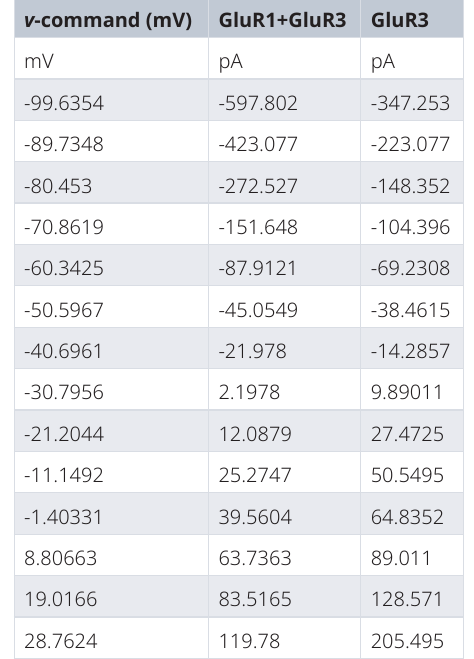
Table 2. Current-voltage relationships for AMPA-Kainate receptors composed of different subunits. The data was digitized from Figure 3B in the article by Hollmann et al. (1991), using the ginput function from the python module matplotlib (Hunter,